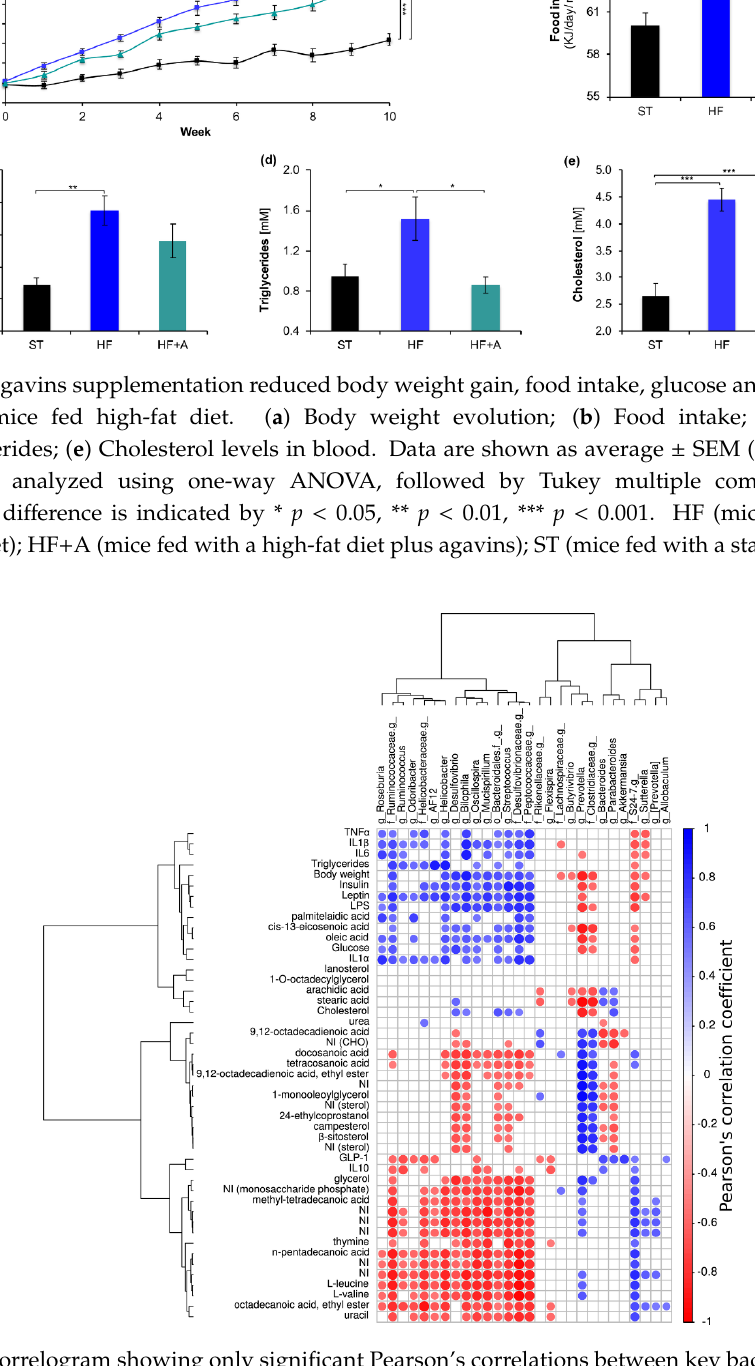
Figure 6. Correlogram showing only significant Pearson’s correlations between key bacterial genera and metabolites, inflammatory biomarkers, hormones, and systemic effects. Blue circles denote a positive correlation while red ones denote a negative correlation.